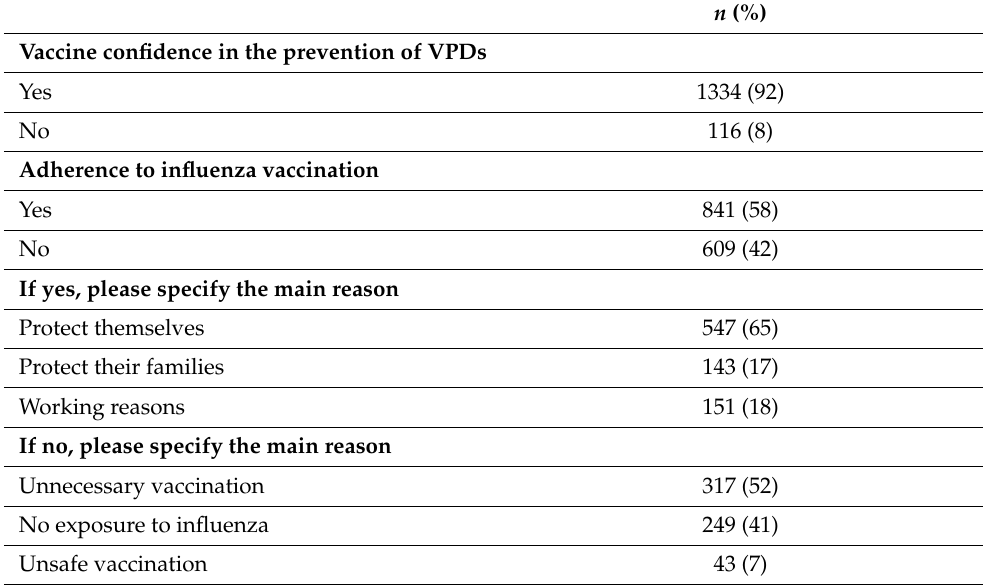
Table 2. Knowledge, attitudes, and perceptions towards anti-influenza vaccination ( n = 1450).